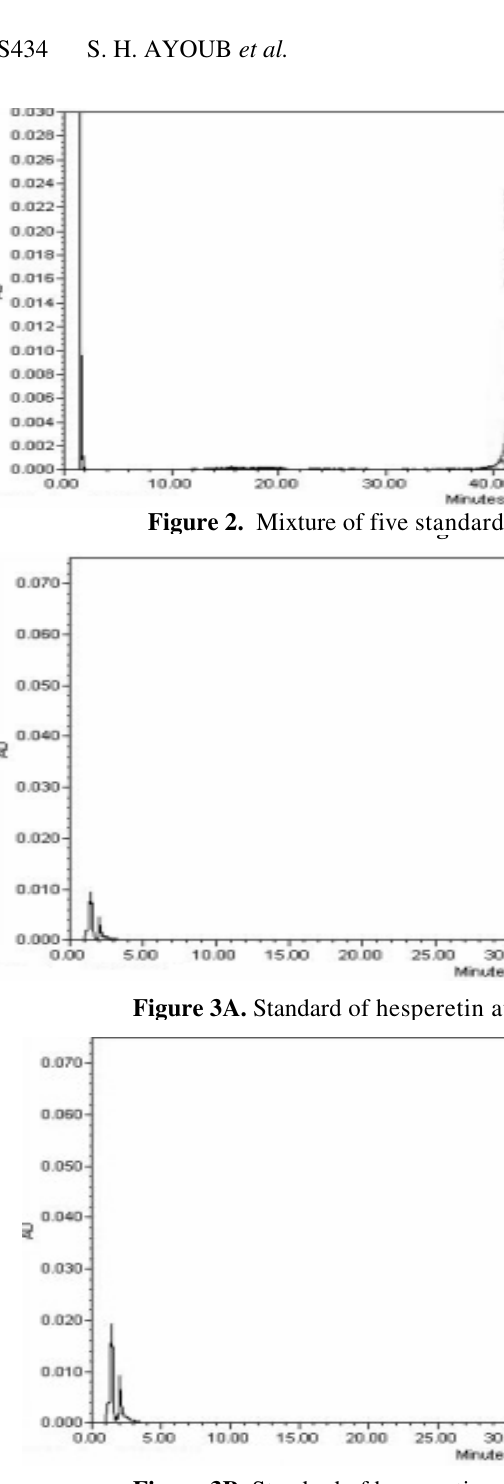
Figure 3B. Standard of hesperetin at 290